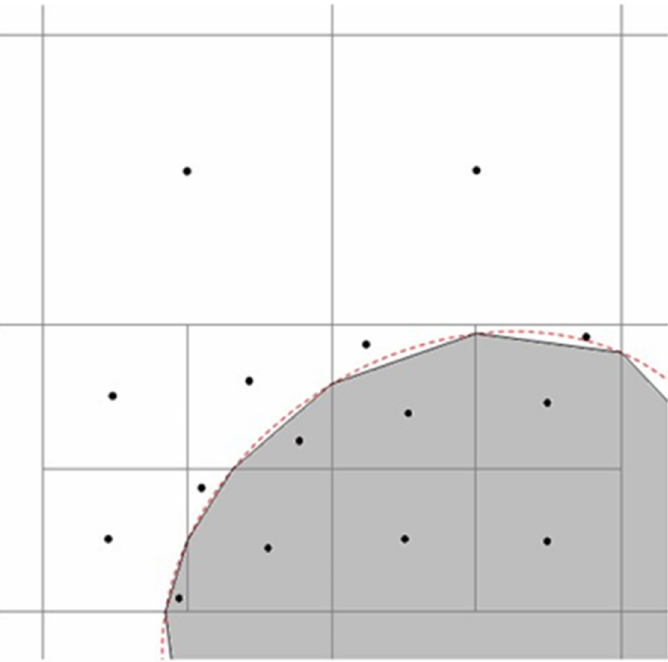
Figure 4. Cell shape in SolidWorks mesh [30].